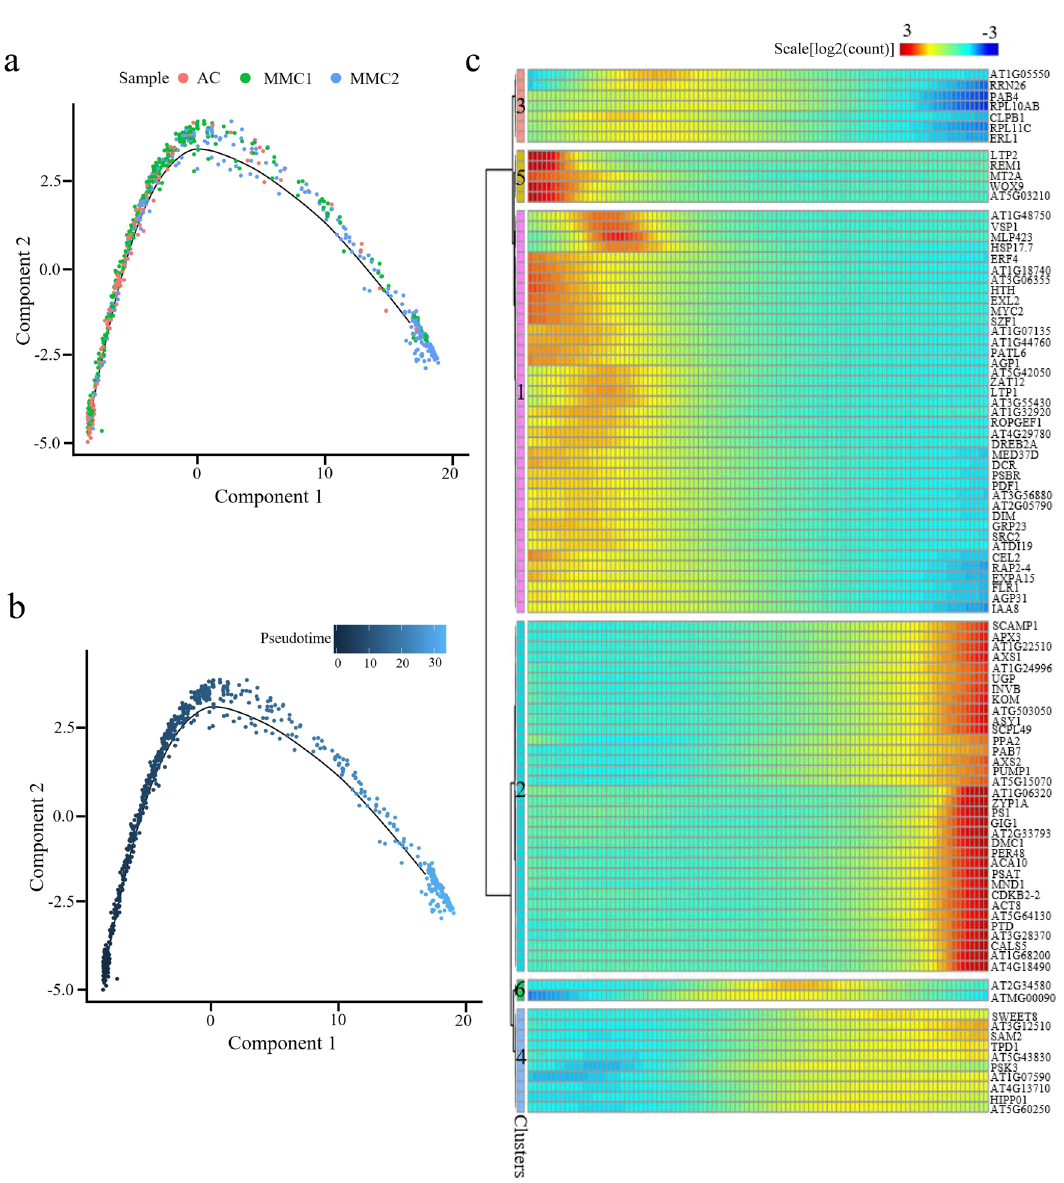
Fig. 7 Reconstruction of the differentiation trajectory in a pseudotime manner. a , b Pseudotime trajectory of the cluster 11. The horizontal and vertical coordinates are two principal components, and the dots on the way represent different cells, in which different colors represent the sample identity ( a ) or the pseudotime ( b ). The color from darkest blue to lightest blue ( b ) represents pseudotime from beginning to end. c Expression heatmap of the top 100 DEGs across pseudotime. The abscissa is in quasi-chronological order, and the ordinate represents one gene per row. Each column represents the average expression value under the current cell state. Rows were grouped based on similarity in gene expression, resulting in six clusters indicated left. The color bar indicates the relative expression